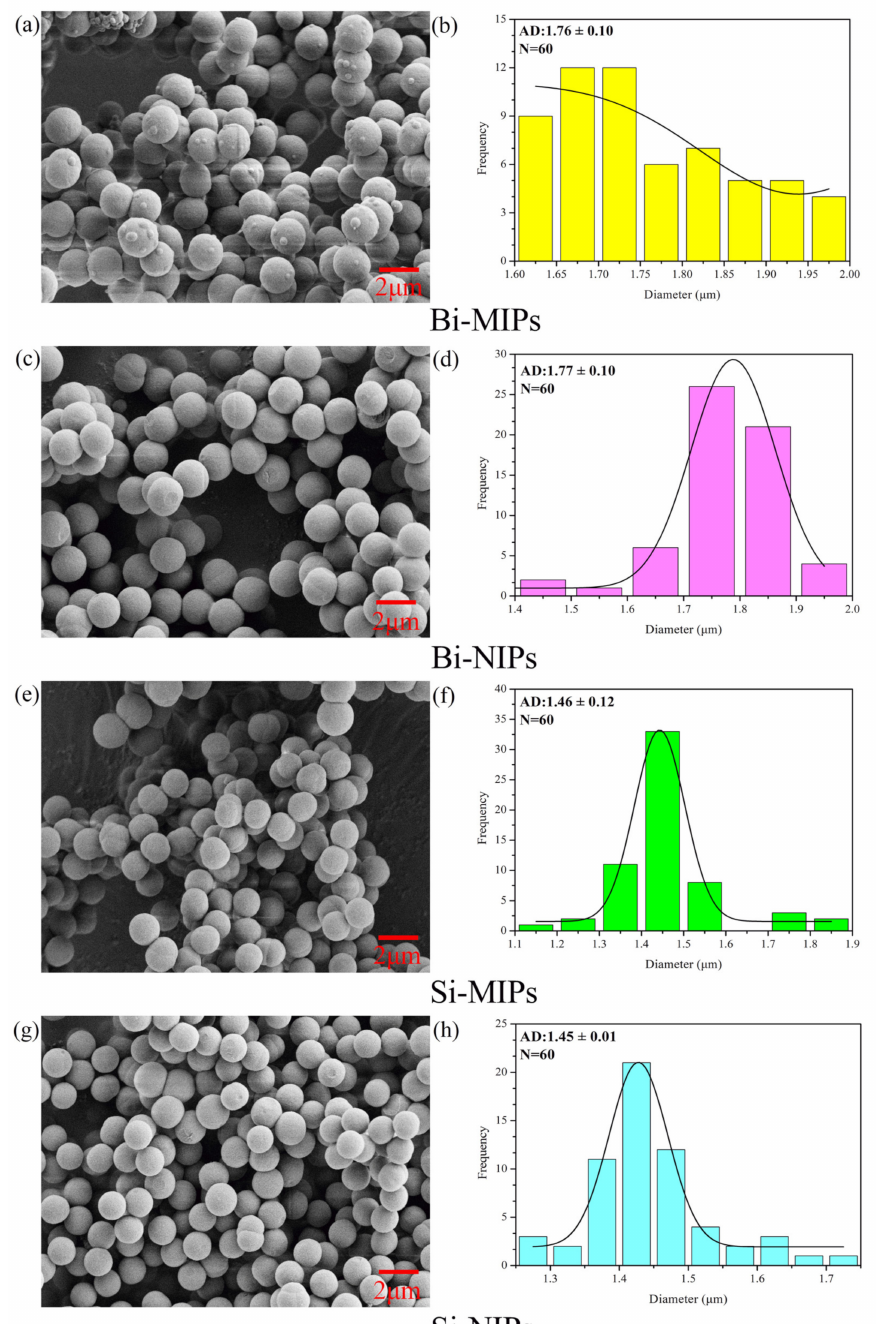
Figure 2. SEM, average particle size and particle size distribution images of Bi-MIPs ( a , b ), Bi-NIPs ( c , d ), Si-MIPs ( e , f ) and Si-NIPs ( g , h